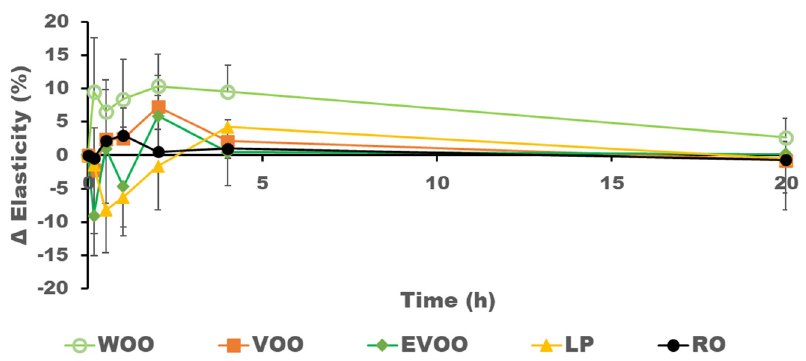
Figure 4. Mean results and variability ( n = 8) in the increase in elasticity (%) at the site of administra- tion during the first 20 h post-application.